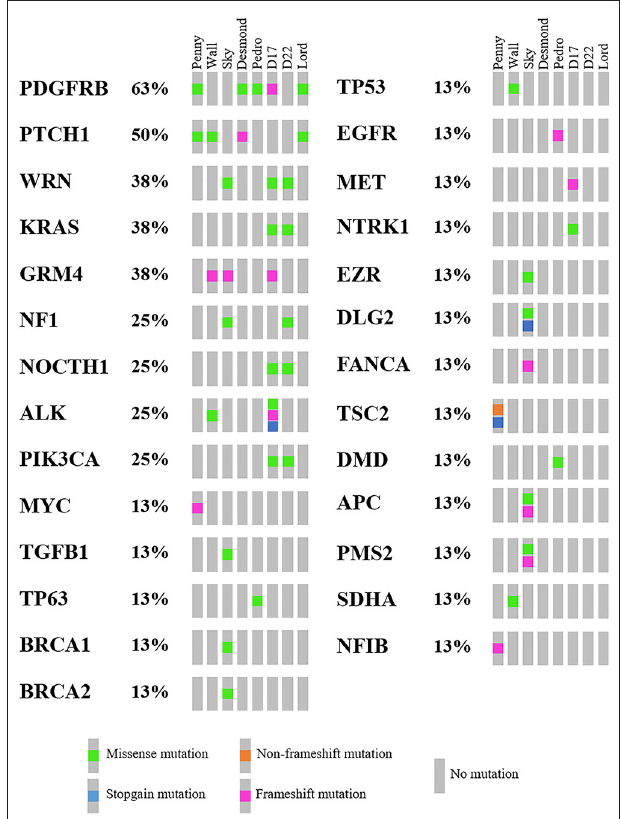
Level included coding for 235 genes, regardless of their incidence across the cell line panel ( Figure 3 and Supplementary Data 2 ). A total